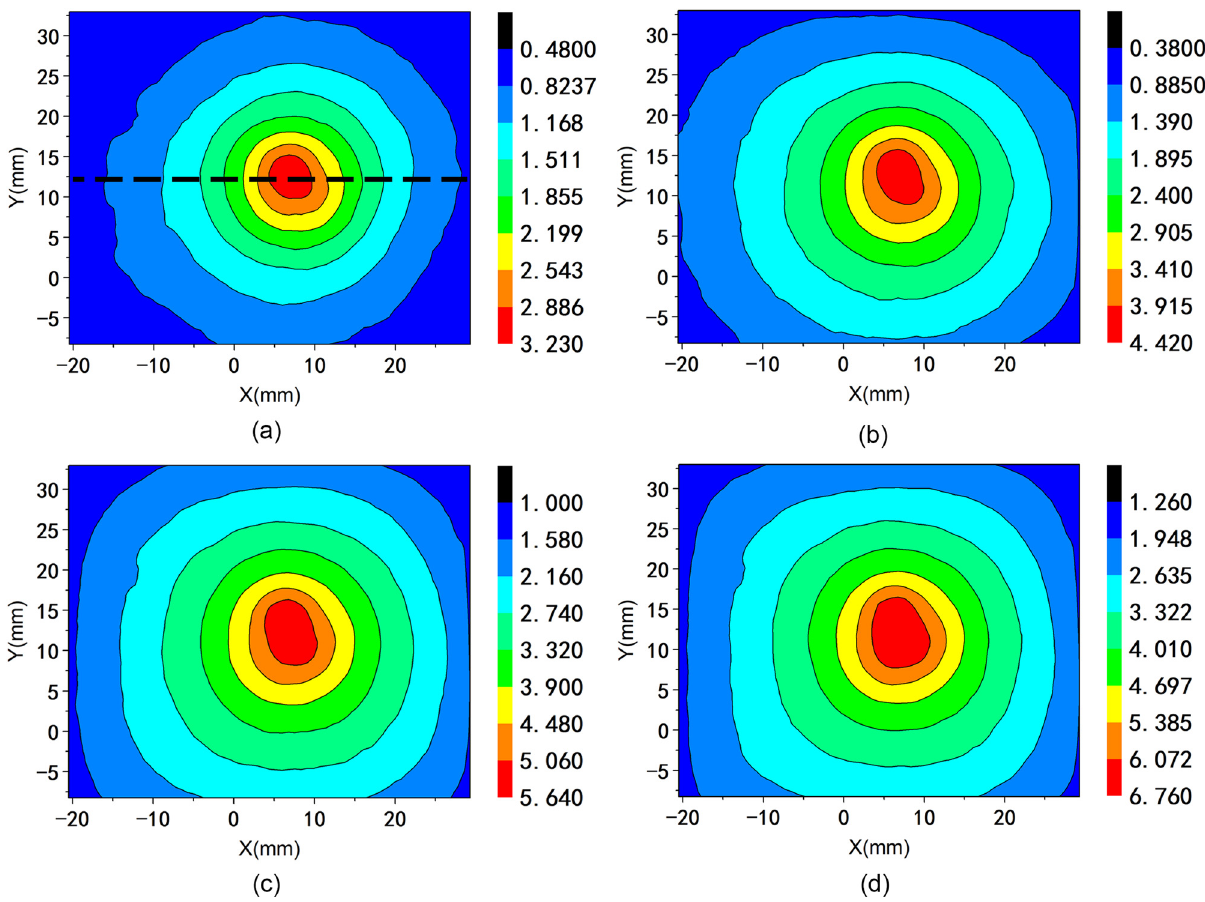
Figure 11: Out - of plane displacement of rear face - sheet: ( a ) 8.5 mm, ( b ) 10 mm, ( c ) 11.5 mm, and ( d ) 13 mm.